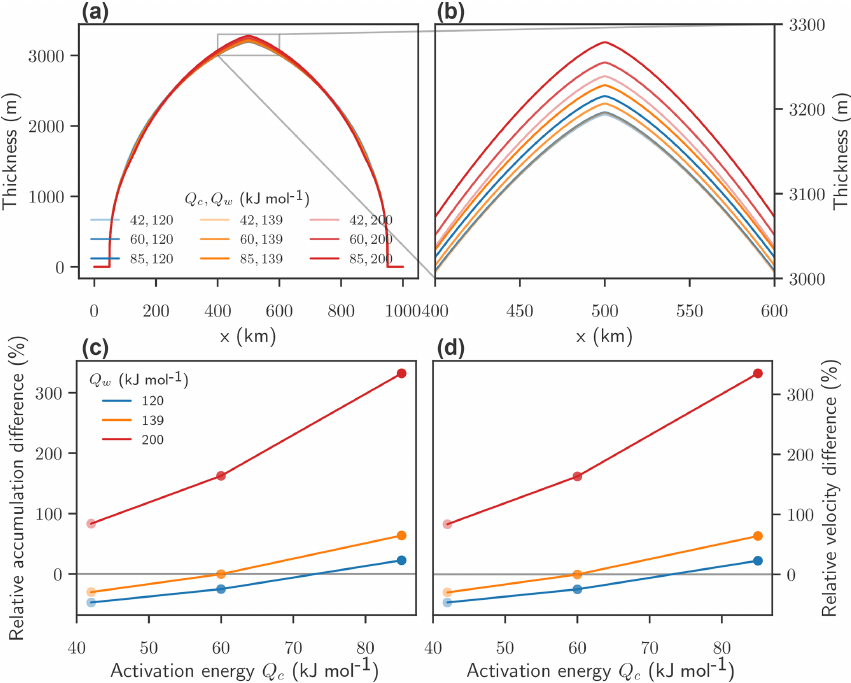
Figure 4. Effect of flow parameters on equilibrium state without warming with adapted accumulation rates and flow exponent n = 3. (a) Thickness profile of equilibrium states for parameter combinations of Q w and Q c , with a zoom on the ice divide (b) . Relative dif- ference of accumulation rates (c) needed to keep the ice-sheet volume in equilibrium close to the reference simulations with standard flow parameters and relative difference in average surface velocities (d) versus Q c . The value of Q w is given by the color.